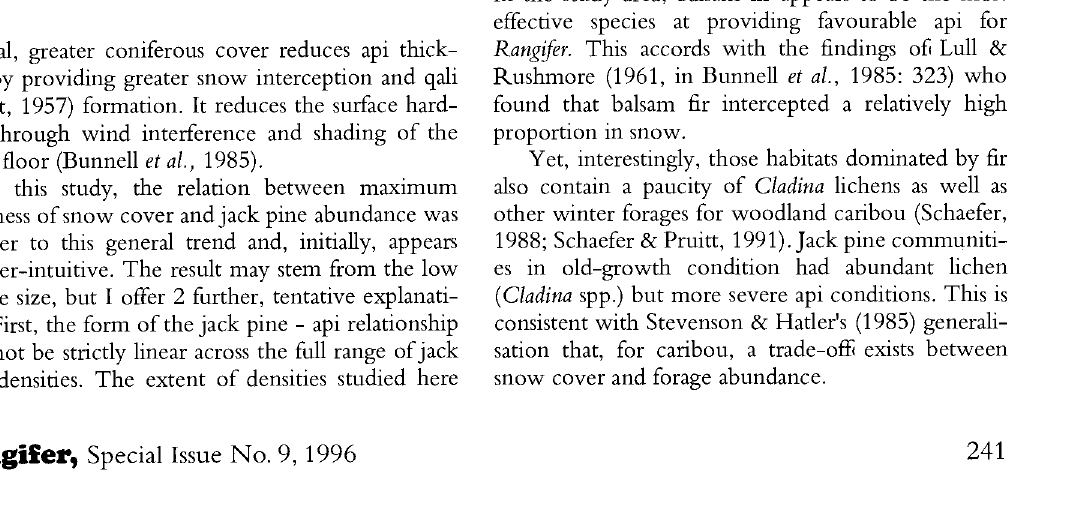
Fig. 1. Maximum total thickness and vertical hardness of api superimposed on a scattergram of lichen (Cladina spp.) abundance and the first principal component of canopy species. Jack pine commu nities tend to the right, mixed spruce/fir/aspen communities to the